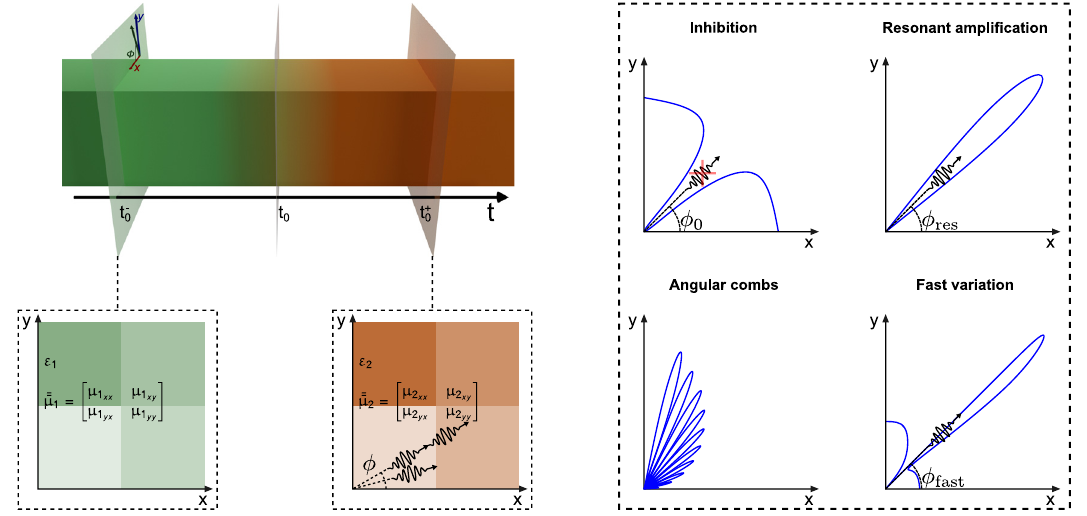
, the material parameters of a two-dimensional (2D) system Figure 1: Schematic depiction of an anisotropic temporal boundary. At time t 0 ,𝜀 ,𝜀 ) to ( 𝝁 ). The interaction of vacuum fluctuations with the dynamical boundary results in photon production suddenly change from ( 𝝁 1 2 z 1 z 2 with a nontrivial angular profile. Engineering the anisotropy of the boundary and its time sequencing enables a variety of vacuum amplification effects, including inhibition of photon production along specific directions, resonant and directive amplification, the generation of angular combs and fast angular variations from inhibition to resonant